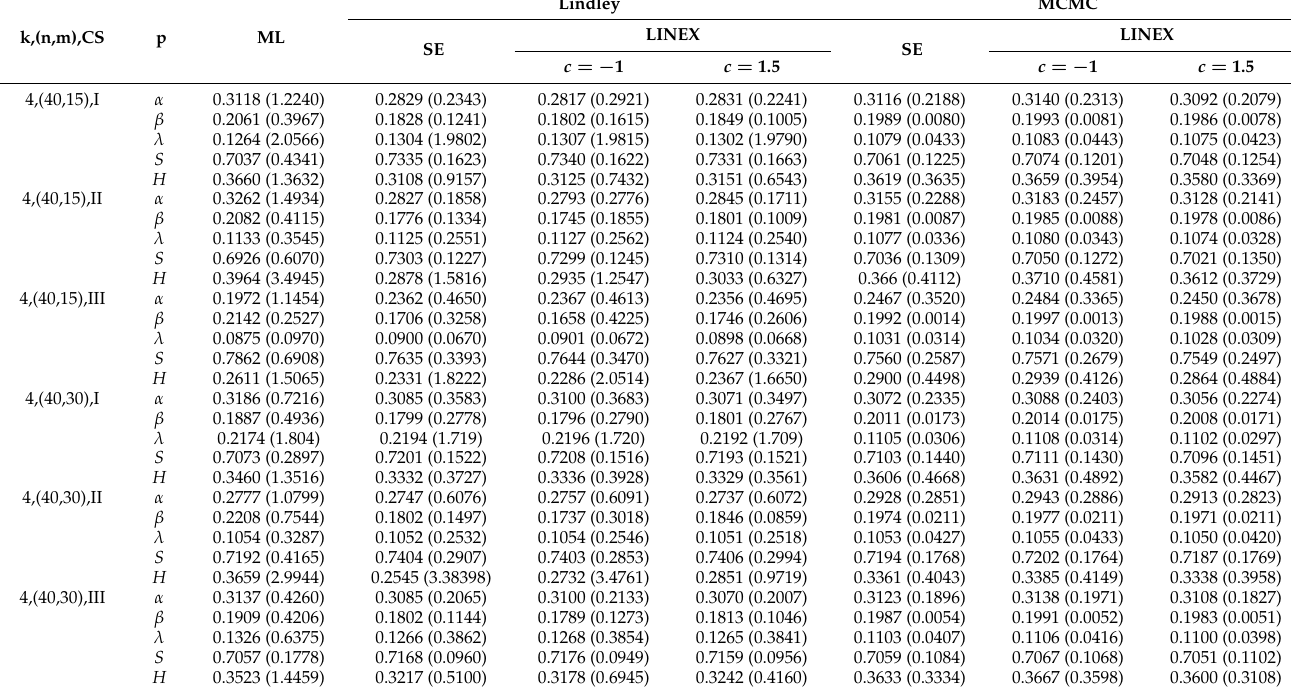
Table 3. AM and (MSE) of estimates for α , β , λ , S , and H .